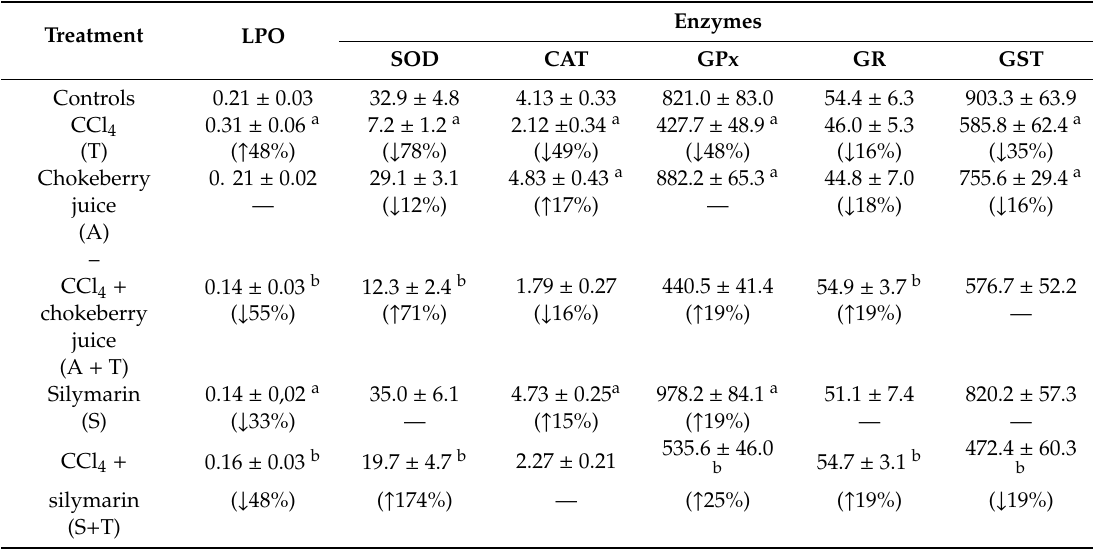
Table 1. E ff ect of chokeberry juice or silymarin on hepatic lipid peroxidation and antioxidant enzymes in the liver of rats treated with carbon